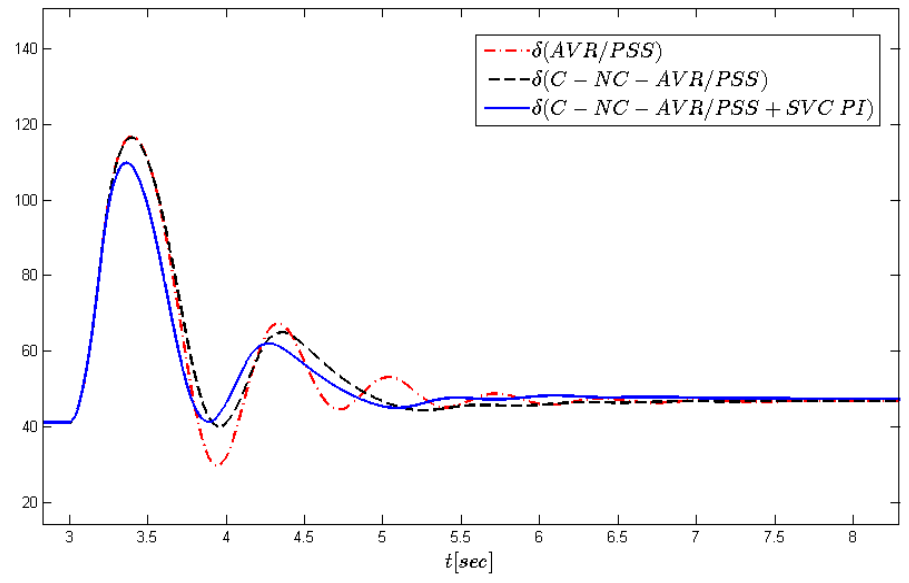
Figure 6. Generator power angle responses (in degrees).